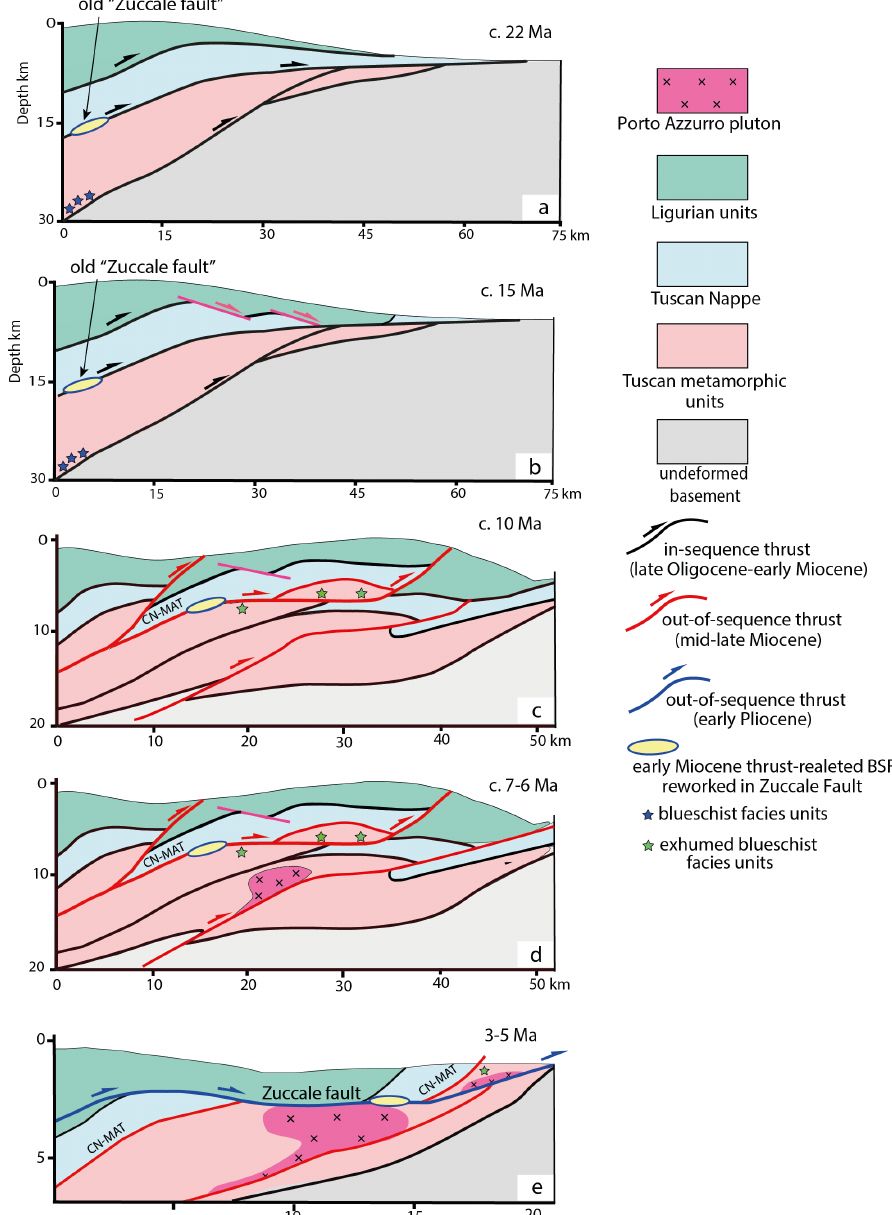
Figure 9. Diagram illustrating the envisaged tectonic evolution of the Northern Apennines belt for the early Miocene–early Pliocene time interval. Note the progressive zooming in to shallower crustal levels for panels (c) – (e) compared to (a) and (b) . Panel (e) zooms into panel (d) and describes a possible scenario for the late Miocene–early Pliocene. Note that, for simplicity sake, the diagrams do not depict the post-Pliocene and still-active extension. (a) Early Miocene nappe stacking with development of east-vergent in-sequence thrusts. Deep metamorphic units experienced HP–LT blueschist facies metamorphism (0.9–1.5GPa). (b) In the mid-Miocene the uppermost wedge was affected by significant extension causing tectonic excision and thinning of the Ligurian units and of the Tuscan Nappe. (c) Late Miocene thrust reactivation and coeval development of east-vergent out-of-sequence thrusts that reshape the early Miocene nappe stack. Deep metamorphic units exhumed to greenschist facies conditions in the upper orogenic wedge are coupled with supra-crustal non-metamorphic to very low metamorphic grade units. (d) The Porto Azzurro pluton emplaced in the late Miocene in a contractional scenario similar to that of (c) (e.g. Mazzarini et al., 2011; Musumeci and Vaselli, 2012; Papeschi et al., 2017). (e) Early Pliocene evolution of central–eastern Elba. The out-of- sequence ZF cuts the nappe stack and Porto Azzurro pluton. Previous Tortonian out-of-sequence thrusts (e.g. the Capo Norsi–Monte Arco Thrust, CN–MAT) were reactivated, cut across, and displaced by the ZF in the early Pliocene ( < 4.9Ma). The architecture of the Northern Apennine belt on Elba was profoundly reshaped by the activity of multiple out-of-sequence thrusts spanning in age from late Miocene to early Pliocene. Solid Earth, 13, 1327–1351,